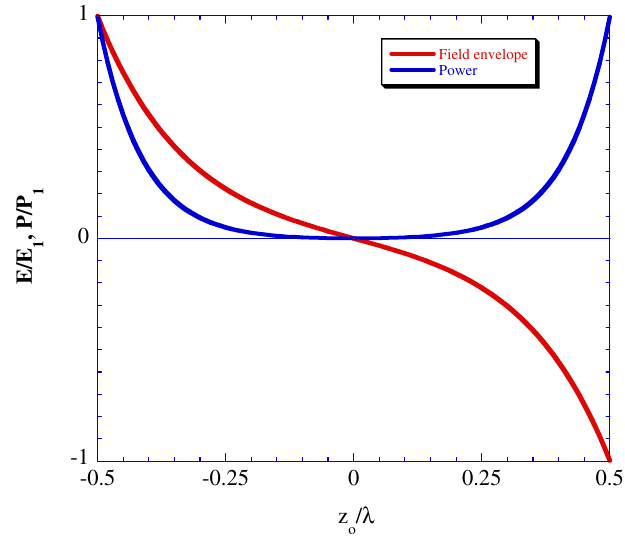
FIG. 4. (Color) Normalized field envelope (red) and the power envelope (blue) for a unit-length tube with cancellation of the evanescent waves. The field and the power are normalized to E 1 and P 1 , correspondingly. This graph uses the unit-length tube ( l i ¼ (cid:1) FM ), and the ratio in BNL’s R&D five-cell cavity between the cutoff and FM frequencies ( (cid:3) 1 (cid:3) (cid:1) FM ¼ 5 : 79